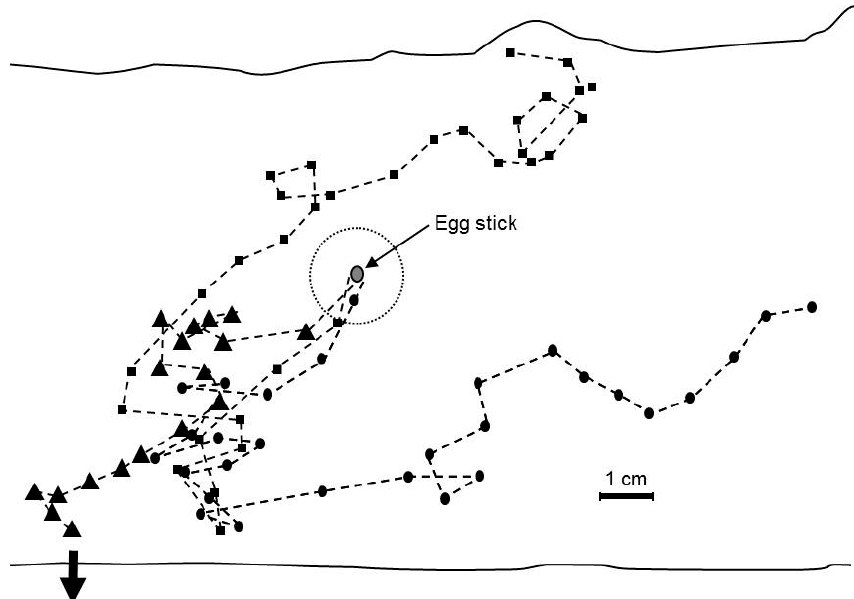
Figure 8. Dispersal pathways of the first three caterpillars to eclose on cladodes sprayed with mandibular gland extract. Circular dashed line encloses the silk-roofed arena. See also Video S5.